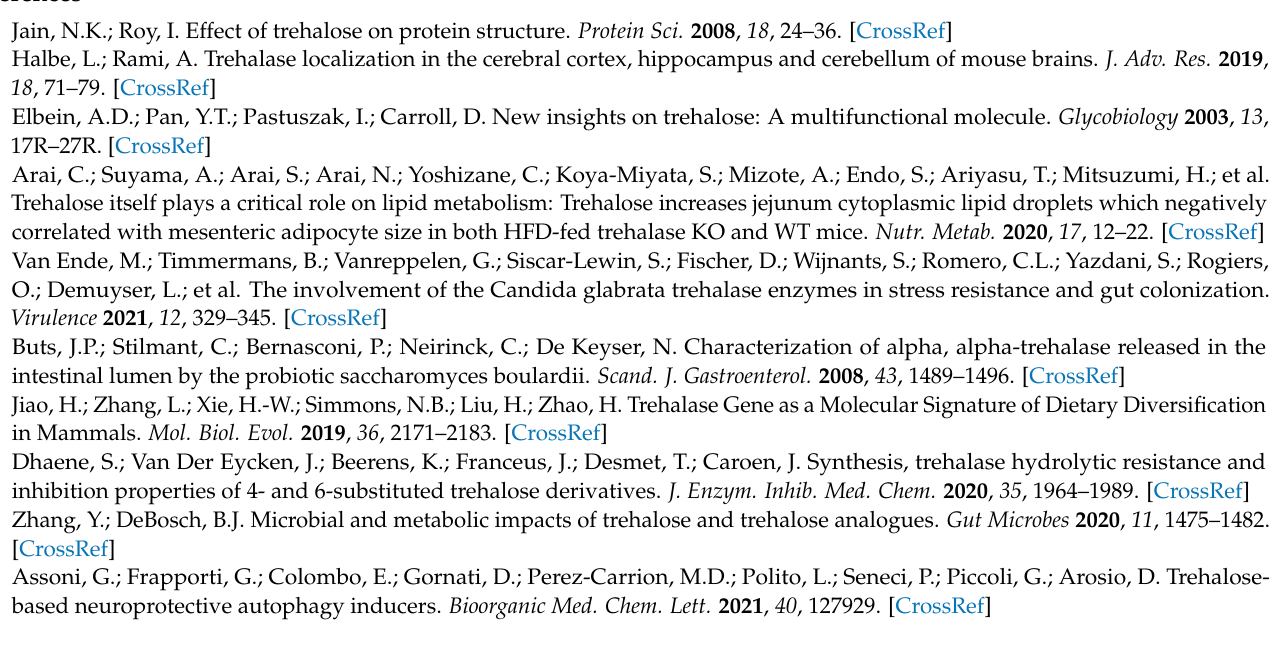
Supplementary Table S2: Time schedule of the experiments on cohort #2. The tables show the animal biography and the schedule of the behavioral